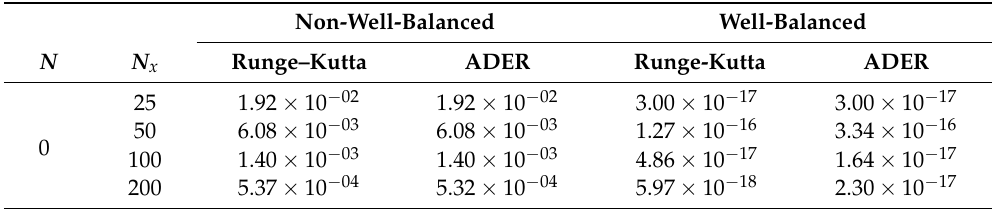
Figure 5. Computed free surface for the stationary problem (51) (sallow-water equations) at time t = 10 s with the fourth order non well-balanced ( left ) and well-balanced ( right ) methods. An uniform Cartesian mesh of N x = 100 elements has been used. Upper and lower panels stands for Runge–Kutta and ADER time-marching discretisations respectively. Table 3. Numerical validation of the well-balanced and non well-balanced methods for the stationary problem (51) (shallow water equations). Table contains L 1 errors for the water depth variable h at a final time t = 10 s for Runge–Kutta and ADER DG schemes of order N + 1 = 1, 2, 3, 4. Uniform Cartesian meshes of N x elements has been